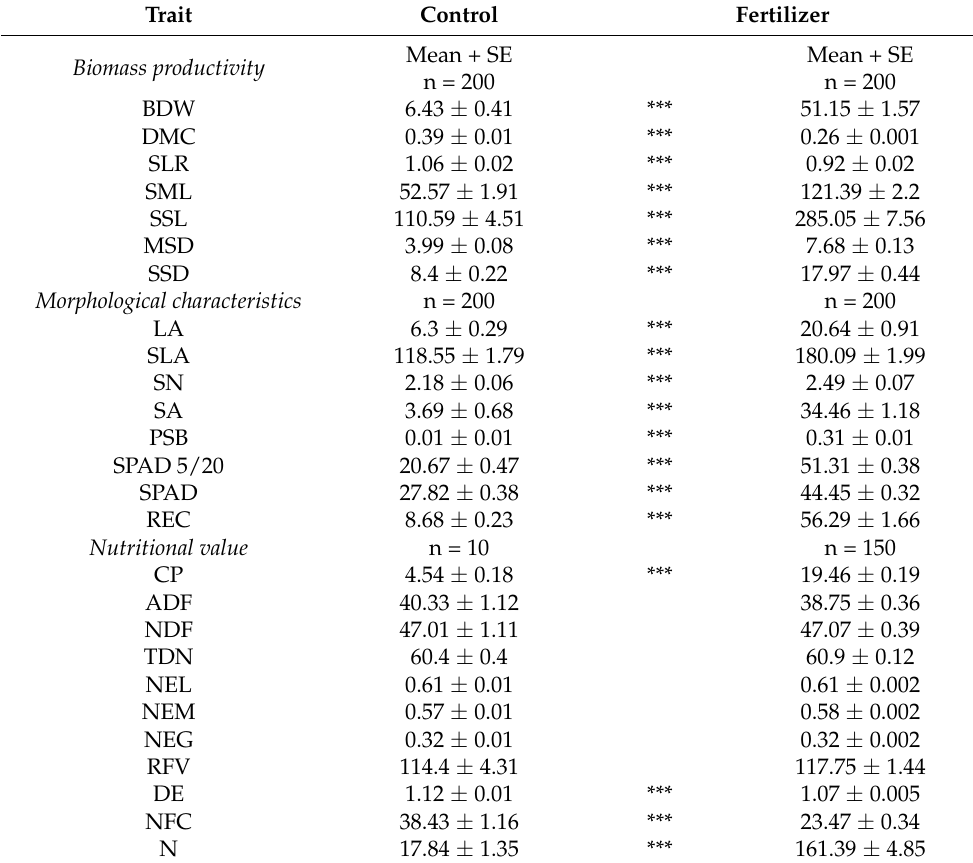
Table 2. Mean values ( ± standard error) of various traits under two experimental treatments. Biomass traits: biomass dry weight (BDW), dry matter content (DMC), stem:leaf ratio (SLR), mean stem length (MSL), sum of stem lengths (SSL), mean stem diameter (MSD), and sum of stem diameters (SSD); morphological traits: leaf area (LA), specific leaf area (SLA), stems number (SN), proportional sylleptic branching (PSB), SPAD, and root electrical capacitance (REC); nutritional value traits: crude protein (CP), acid detergent fiber (ADF), neutral detergent fiber with α -amylase and sodium sulfite (aNDF), no fiber carbohydrates (NFC), relative feed value (RFV), total digestible nutrients (TDN), net energy for lactation (NEl), net energy for maintenance (NEm), net energy for gain (NEg), digestible energy